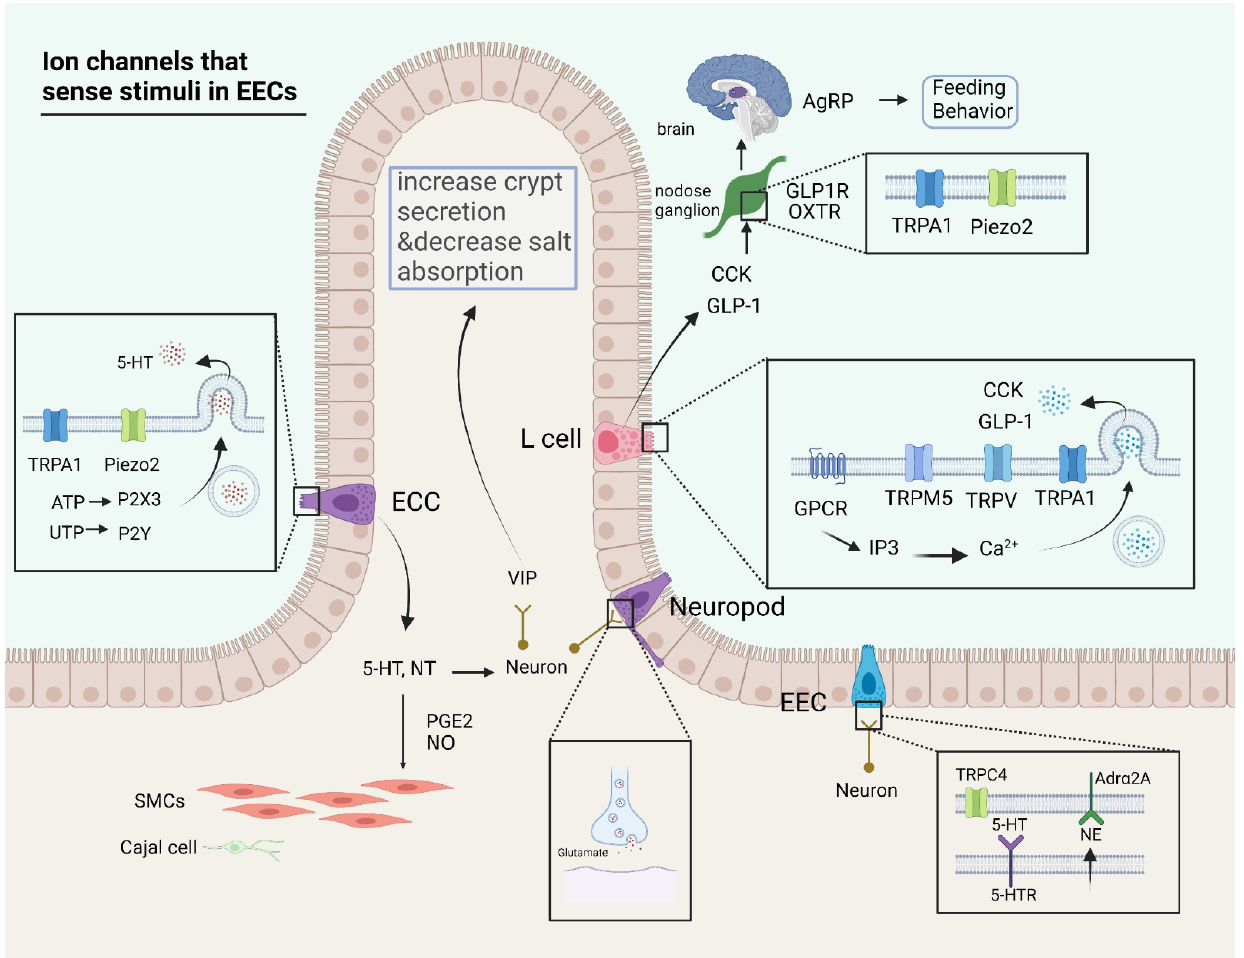
Figure 1. Ion channels that sense stimuli in enteroendocrine cells (EECs). The role of ion channels in signal sensation and transmission in EECs includes secretion of hormones, excitation of neurons, contraction of smooth muscle, and transmission of neuron-mediated signals. (1) 5-HT and neurotensin (NT) secreted by ECCs are related to calcium currents mediated by ion channels such as transient receptor potential ankyrin 1 (TRPA1) and Piezo2. Hormones such as 5-HT are able to elicit contractile activity in smooth muscle cells (SMCs), with the involvement of prostaglandin E2 (PGE2) and nitric oxide(NO). (2) L cells are capable of producing glucagon-like peptide-1 (GLP-1)and cholecystokinin (CCK) under the action of calcium currents, with the participation of G protein coupled receptor(GPCR), transient receptor potential melastatin 5 (TRPM5), transient re- ceptor potential vanilloid(TRPV), TRPA1, which can generate satiety signals in the brain through the action of permutations in the nodal ganglia and thus control feeding behavior. (3) Neuropod cells are capable of producing synaptic connections directly with neurons and transmit signals for neurotransmitters through glutamate. (4) A portion of EECs are capable of producing bidirectional communication with neurons through norepinephrine (NE) and 5-HT as mediators. (created with BioRender.com) EECs receive mechanical and chemical stimuli through ion channels and regulate their secretory activities through complex signaling mechanisms. ECCs have electrical excitability owing to abundant Na channel and K channel expression [11], along with transient receptor potential ankyrin 1 (TRPA1) [11,18] for sensing chemical stimuli and Piezo2 [17,22] for sensing mechanical stimuli. Characterized by ChgA and NeuroD1 , re- spectively, ECCs were activated by allyl isothiocyanate (AITC) and mechanical forces to generate inward Ca 2+ currents. Ca 2+ currents and vesicular cytosolic coupling result in the